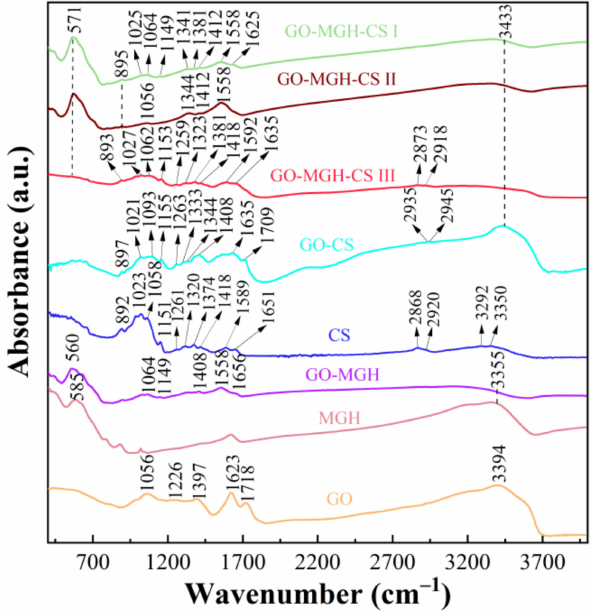
Figure 3. The FTIR spectrum of the original materials and